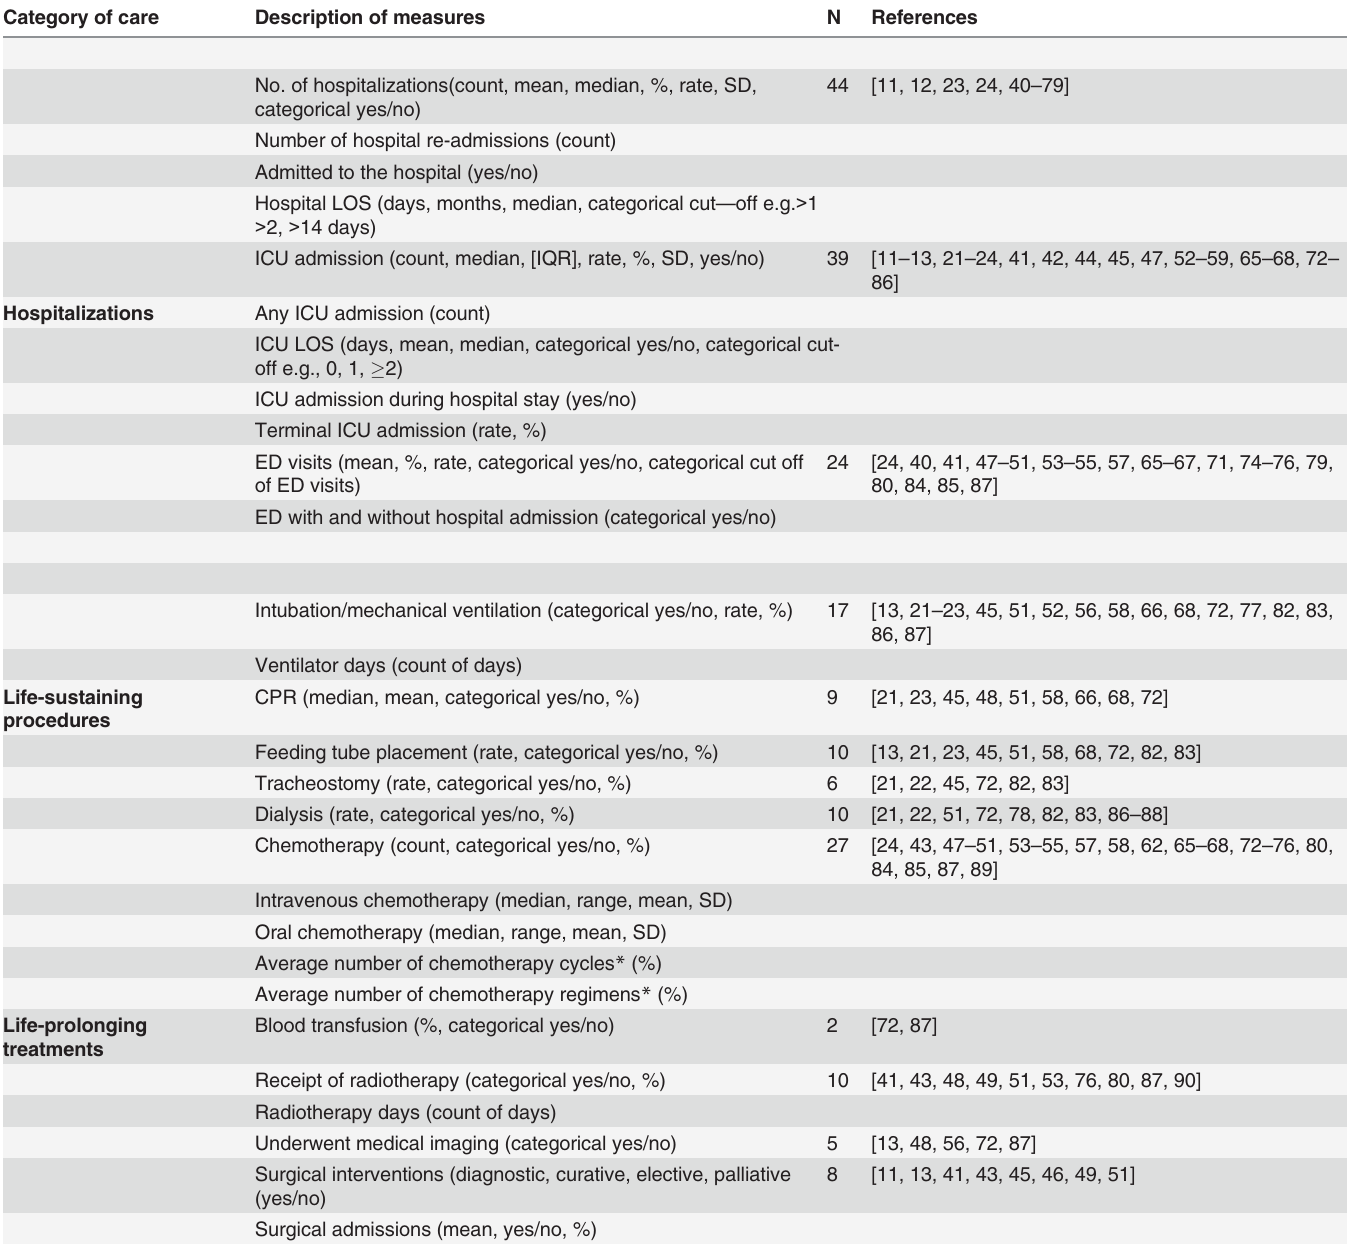
Table 2. Summary of intensity of end of life care measures from included studies. Category of